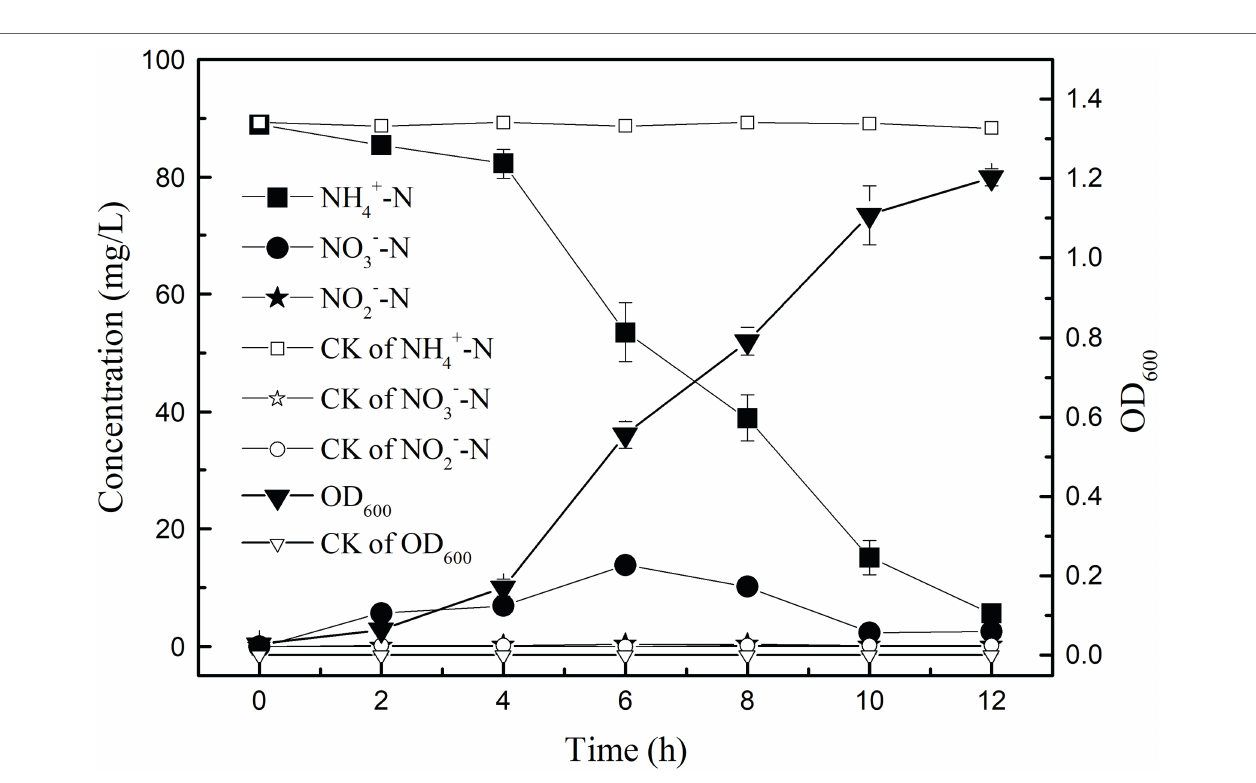
FIGURE 3 | Growth curve and heterotrophic nitrifying characteristics of strain K17. The mixture was cultured at 165 rpm and 30 ° C for 12